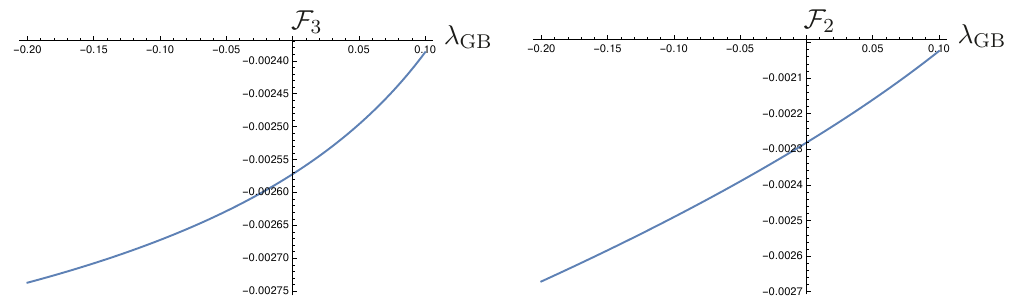
Figure 1 . Parameterization of the equilibrium equation of state of the holographic non-conformal GB model (2.1) with the equation (2.17) for deformation of the UV conformal fixed point with ∆ = 3 (left panel) and ∆ = 2 (right panel) operators. Note that the causality window, the speed of sound is bounded from above by its conformal value.